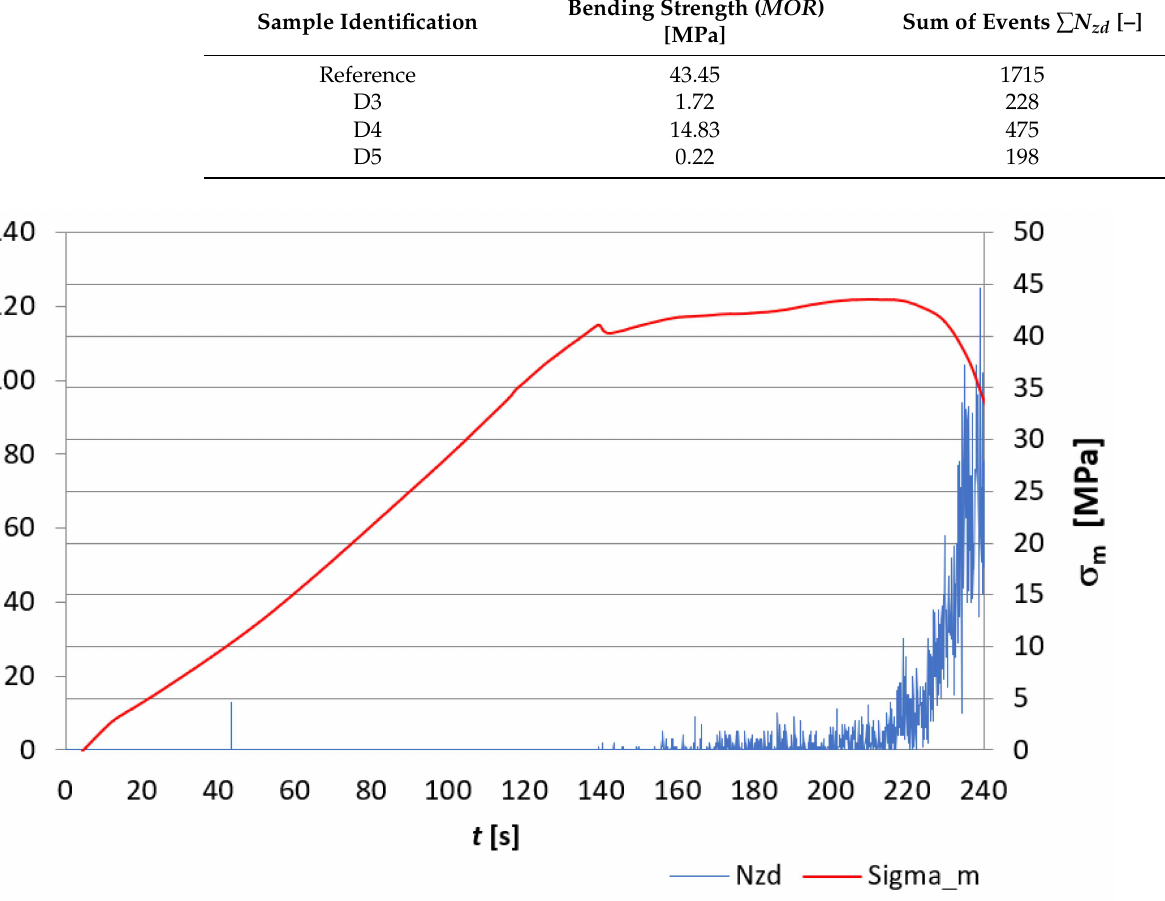
Figure 7. Recording of the event rate N zd and bending stress σ m versus time for the reference